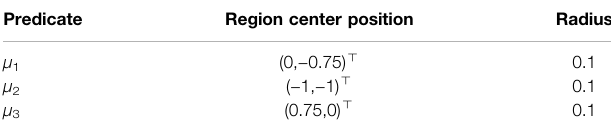
TABLE 3 | Geometric characteristics of regions of interest for a child-robot interaction scenario. μ 1 and μ 3 are inside r 1 and μ 2 is inside r 2 . Predicate